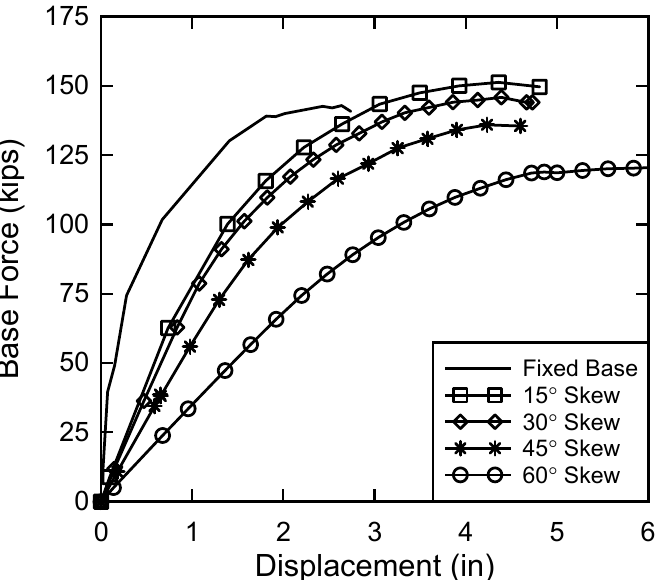
Figure 11. The force–displacement curves from pushover analysis for Design Case 1 at end of wall segment.